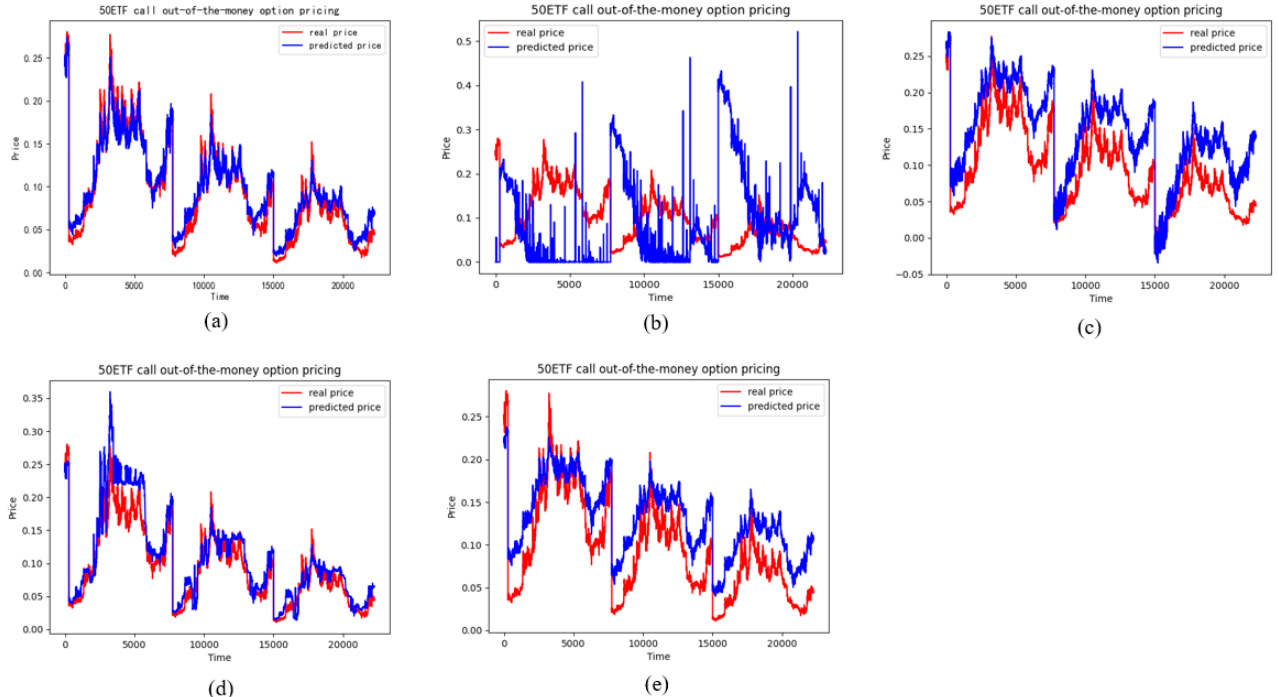
Figure 15. The pricing performance of OTM call options on each model ( a ) stands for the LSTM model, ( b ) stands for the BS model, ( c ) stands for the SVM model, ( d ) stands for the Random forests model, ( e ) stands for the RNN model.